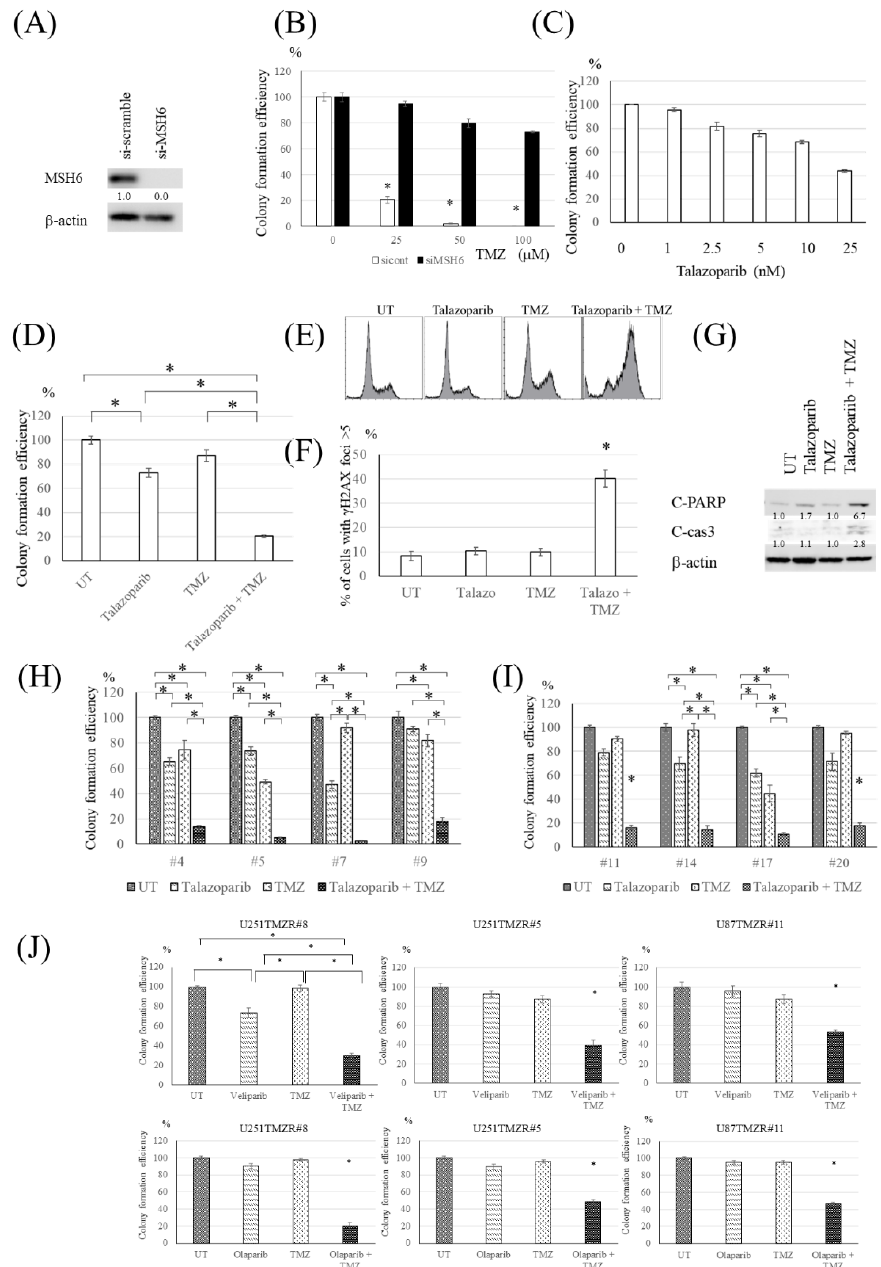
Figure 3. PARP inhibitor resensitized the TMZ-resistant U251 cells harboring MMR deficiency to TMZ. ( A ) Western blot analysis of MSH6 and β -actin levels in U251 cells treated with siRNA targeting MSH6 or non-targeting siRNA. ( B ) Colony formation efficiency of control and MSH6-suppressed U251 cells following TMZ exposure (0–100 µ M, 3 h). ( C ) Colony formation efficiency of U251TMZR#8 cells following talazoparib exposure (0–25 nM, 4 days). ( D ) Colony formation efficiency of U251TMZR#8 cells following talazoparib (2.5 nM, 4 days), and/or TMZ (100 µ M, 3 h). ( E ) Fluorescence-activated cell sorting (FACS) analysis of cell cycle distribution in U251TMZR#8 after talazoparib and/or TMZ exposure. ( F ) Quantitative data from immunofluorescence analysis of γ -H2AX foci in U251TMZR#8 cells treated with talazoparib and/or TMZ. ( G ) Western blot analysis of cleaved PARP, cleaved caspase 3, and β -actin levels in U251TMZR#8 cells treated with talazoparib and/or TMZ. ( H ) Colony formation efficiencies of U251TMZR#4, #5, #7, and #9 cells following talazoparib (2.5 nM, 4 days) and/or TMZ (100 µ M, 3 h). ( I ) Colony formation efficiency of U87TMZR#11, #14, #17, and #20 cells following talazoparib (2.5 nM, 4 days) and/or TMZ (100 µ M, 3 h). ( J ) Colony formation efficiency of U251TMZR#8, #5, and U87TMZR#11 cells following veliparib (1 µ M, 4 days) or olaparib (1 µ M, 4 days) and/or TMZ (100 µ M, 3 h)., * p <